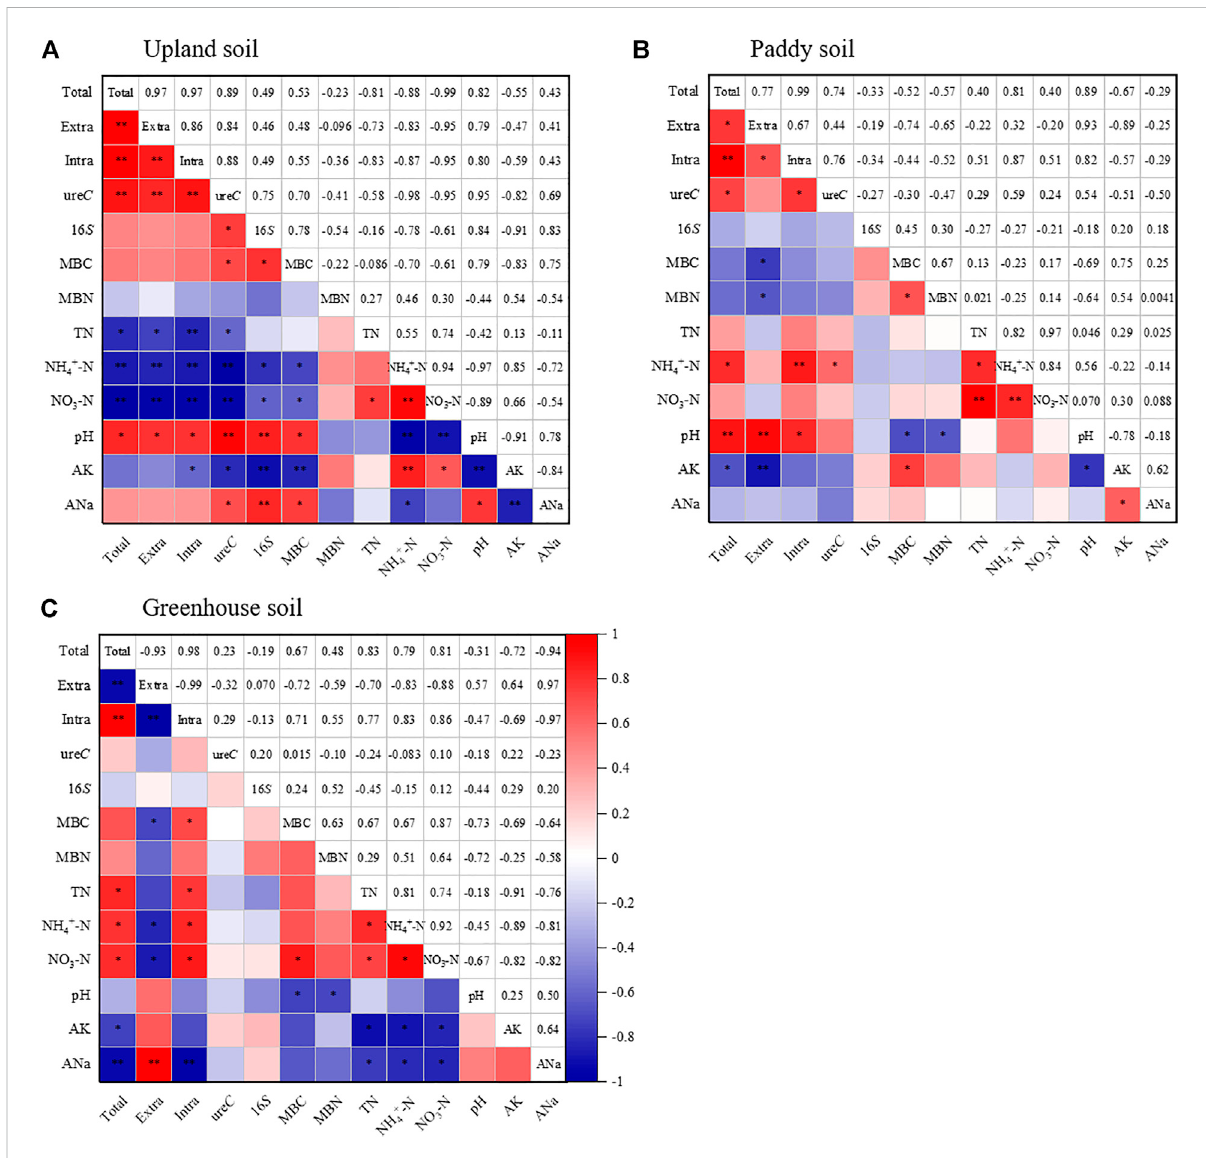
FIGURE 5 Correlationsofsoilproperties,ureaseactivityofvariouspools,totalbacteriaand ureC geneabundancesintheuplandsoil (A) ,paddysoil (B) and greenhouse soil (C) . Warm and cold color represent positive and negative correlations, respectively. Signi fi cant correlations are highlighted with asterisks * p < 0.05; ** p <